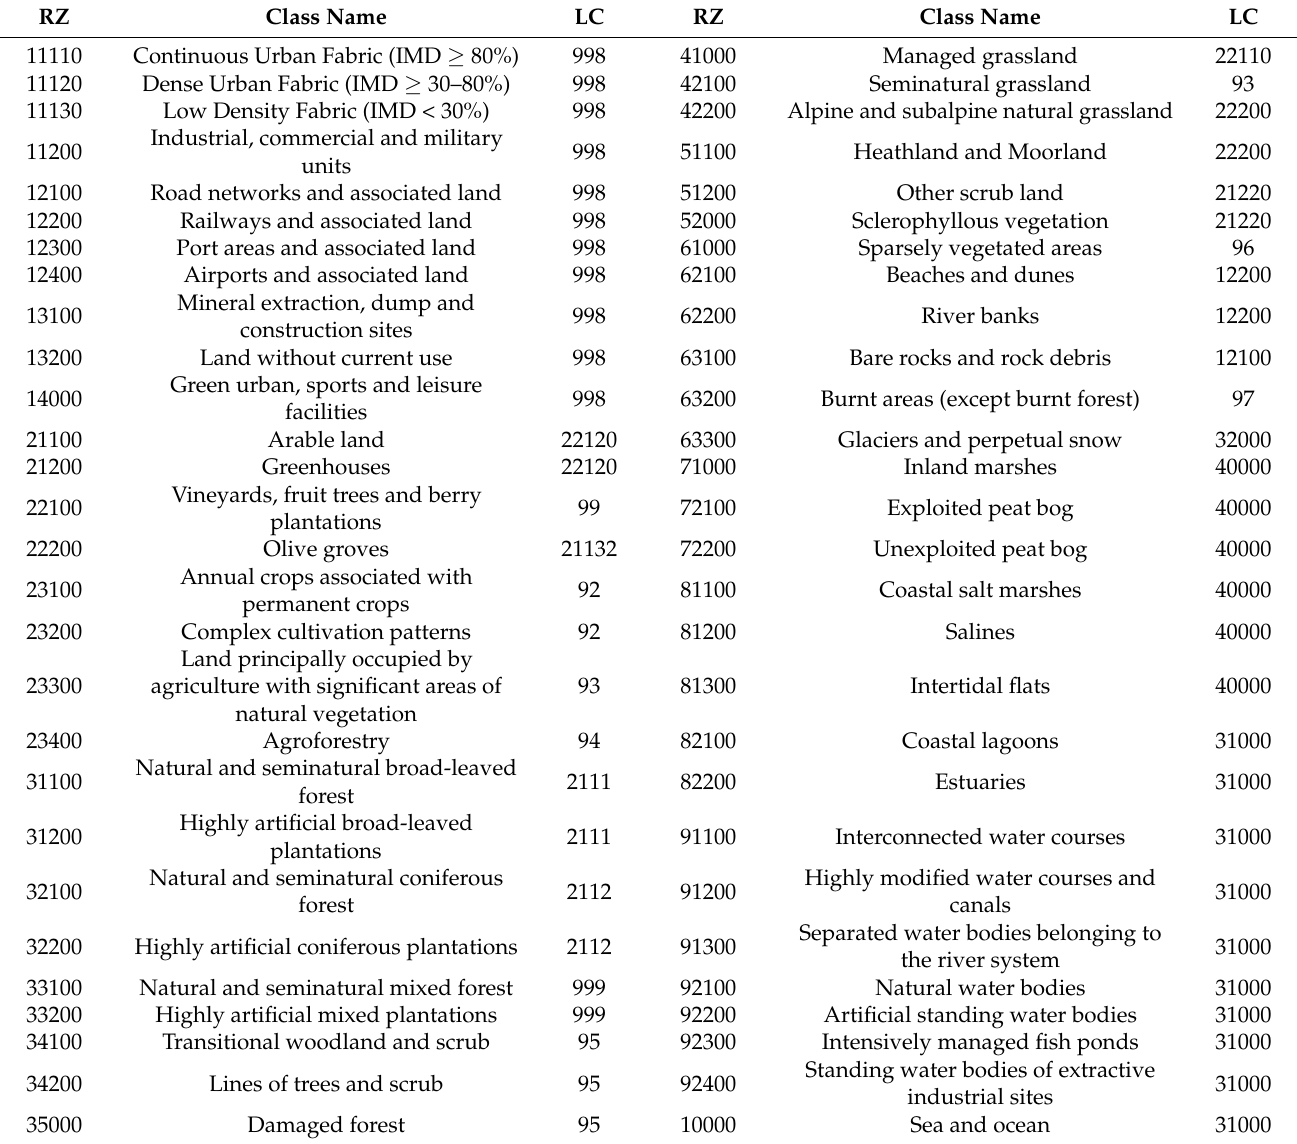
Table A3. Reclassification table for RZ.